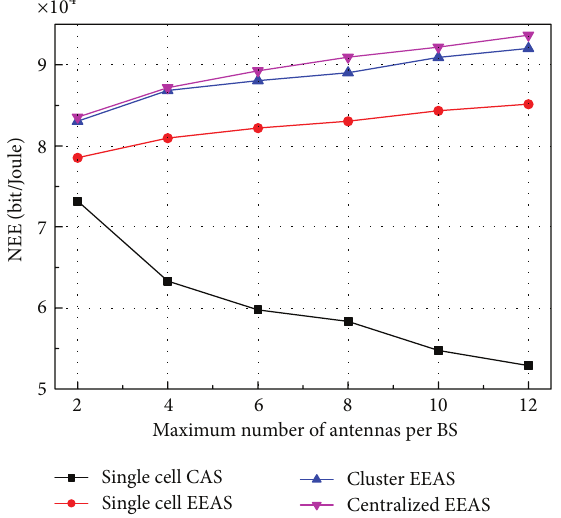
Figure 4: NEE versus maximum number of antennas per BS with 𝑃 = 20 W, 10 users per cell, and cell radius of 1Km.